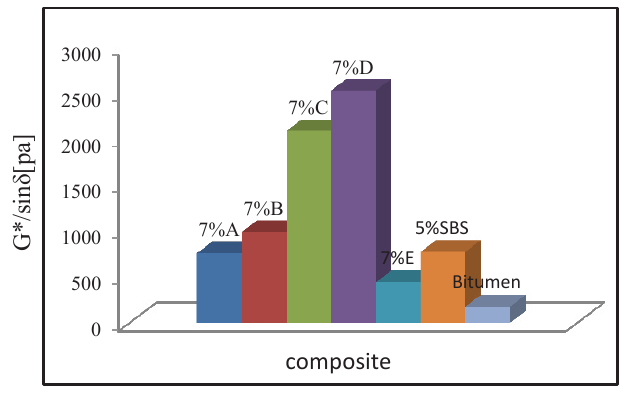
Fig. 10. rutting resistance of pure bitumen and the modified